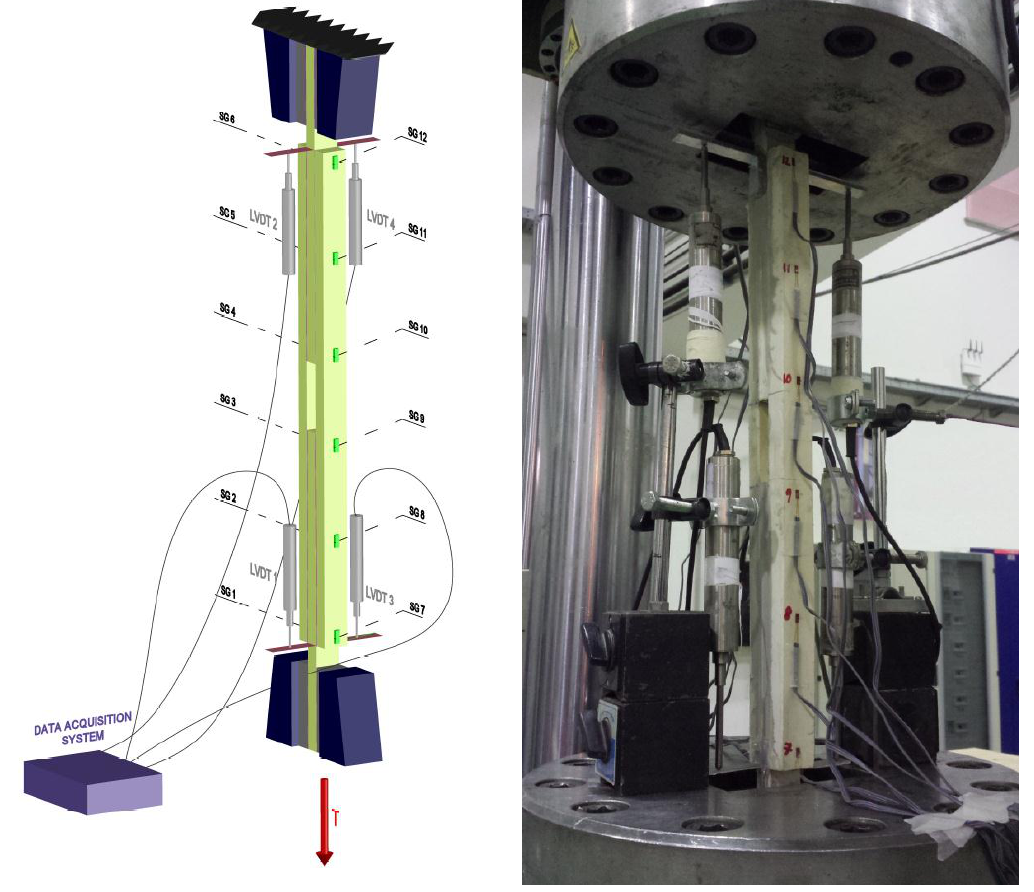
Figure 9. Main experiments. Experimental setup.